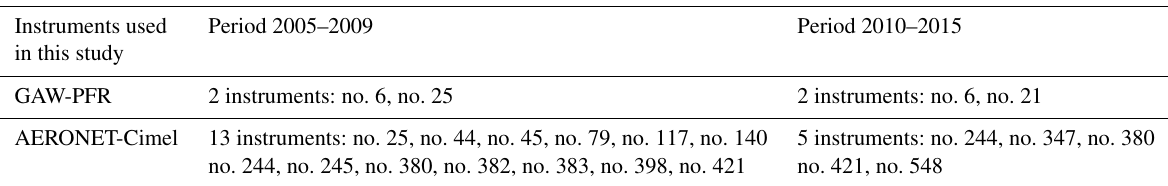
Table 2. GAW-PFR and AERONET-Cimel instrument numbers used in this study in the period 2005–2015. Data from reference Cimel no. 398 were not upgraded to level 2 in V3 during the period 12 July–15 September 2008. Instruments